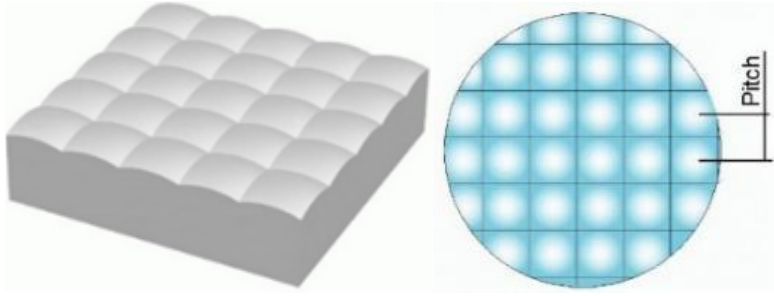
Figure 11. Array positive orthogonal — APO.